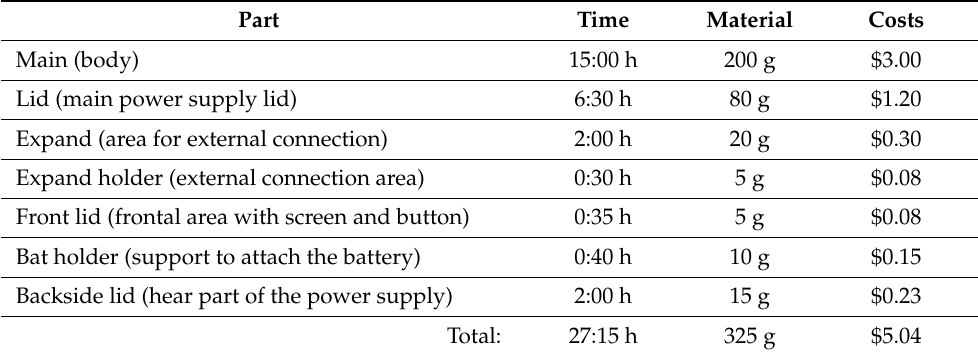
Table 3. Printable parts and respective printing times, material in grams and costs per part.